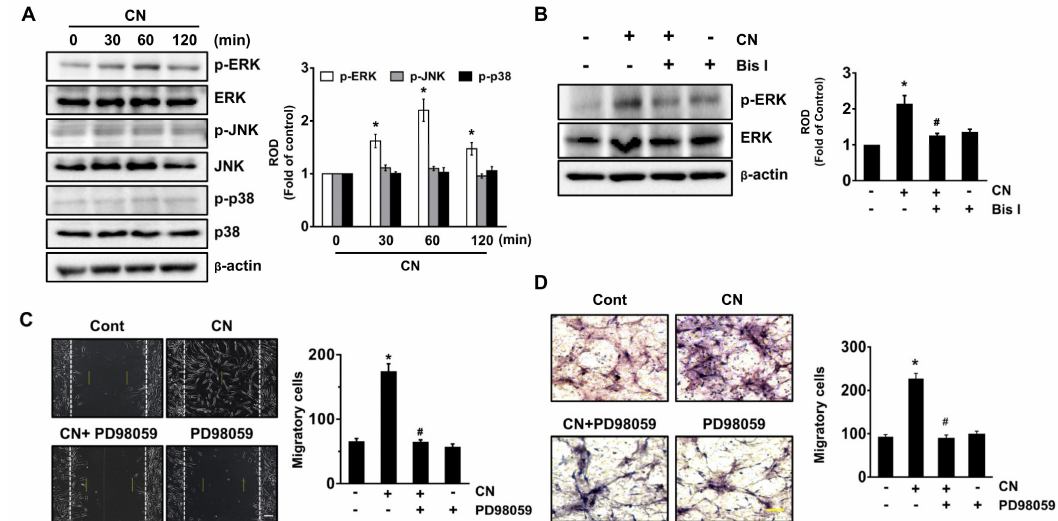
Figure 4. CN uniquely regulates the ERK pathway responsible for the cell migration. ( A ) Time responses of phosphorylation of mitogen-activated protein kinases (MAPK) in cells exposed to CN for 120 min are shown. Data represent the means ± S.E. n = 3. * p ≤ 0.01 vs. 0 min. ( B ) Cells were pretreated with Bis I for 30 min prior exposure to CN for 60 min. The level of phosphorylation of MAPK was determined by western blot. Data represent the means ± S.E. n = 4. * p ≤ 0.01 vs. control. # p ≤ 0.05 vs. CN alone. ( C ) Cells were pretreated with ERK inhibitor, PD98059 (10 µ M) for 30 min prior exposure to CN for 24 h. Cell migration was determined by wound-healing migration assay (left panel) and quantified (right panel). Scale bar represents 100 µ m (magnification, × 100). n = 3. * p ≤ 0.01 vs. control. # p ≤ 0.001 vs. CN alone. ( D ) The migration capacity of UCB-MSCs treated with CN for 24 h was assessed in transwell permeable support with 8.0 µ m pore size membrane coated with Matrigel. Data represent the means ± S.E. n = 3. Scale bars represent 100 µ m (magnification, × 200). * p ≤ 0.001 vs. control. # p ≤ 0.01 vs. CN alone. ( A , B ) ROD is the abbreviation for relative optical